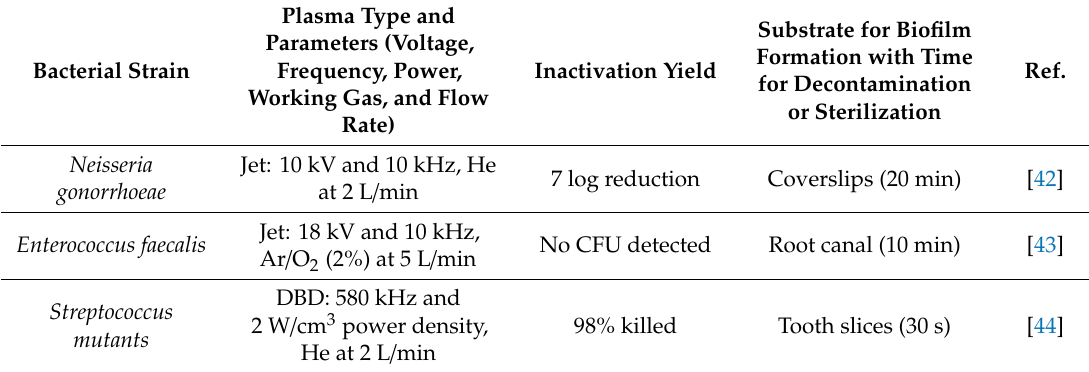
Table 2. Uses of non-thermal plasma (NTP) for biofilm decontamination or